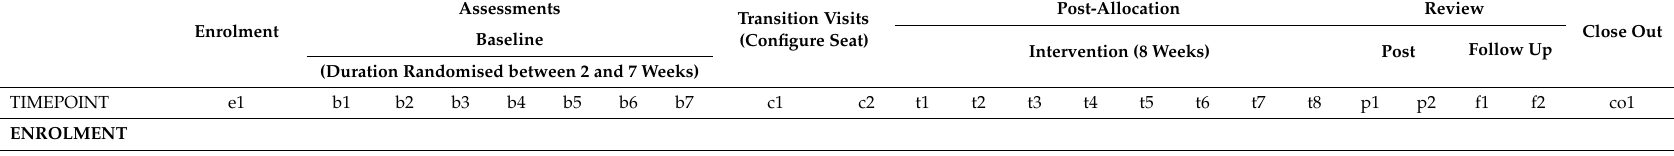
Transition Visits (Configure Seat)